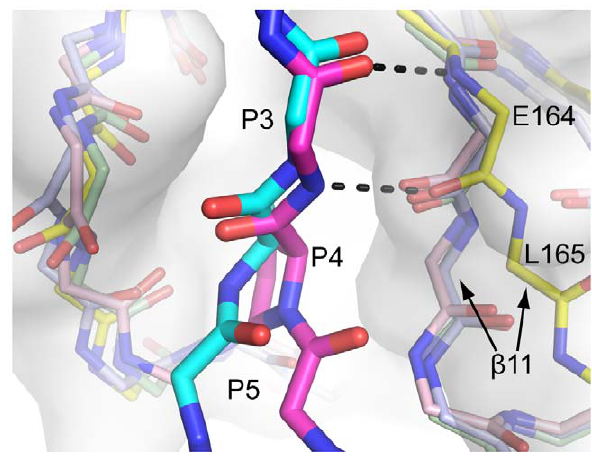
Figure 4. IBV 3CL pro has a wider substrate-binding pocket to accommodate substrate containing P4-Pro. The structure of IBV 3CL pro (PDB: 2Q6D, yellow cartoon and white surface) is superimposed with 3CL pro from HCoV-229E (PDB: 1P9S, light blue), HCoV-HKU1 (PDB: 3D23, light green), and SARS-CoV (PDB: 2Q6G, pink) [31,32,33]. The structure of WT substrate (magenta) is derived from crystal structure of SARS-CoV 3CL pro in complex with the autocleavage sequence (TSAVLQ Q SGFRKM) (PDB: 2Q6G) [31]. The structure of the A4P substrate variant (cyan) was modeled based on the crystal structure of IBV 3CL pro in complex with its own autocleavage sequence (PDB: 2Q6D) [31]. Note that strand-11 of IBV 3CL pro is positioned further away from P4 to P5 positions, resulting in a wider substrate-binding